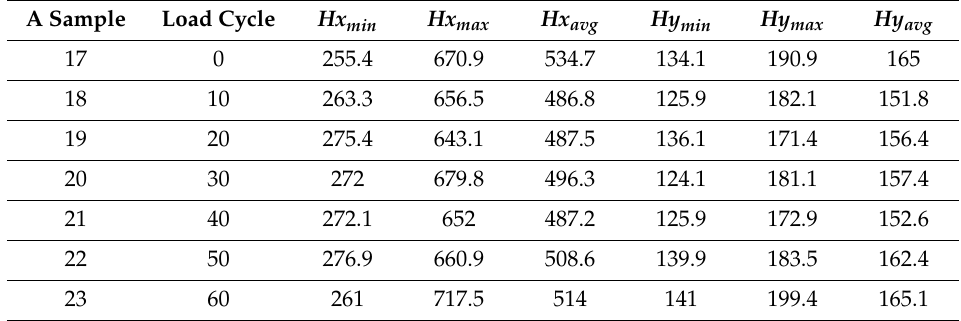
Table 2. Minimum, maximum, and average values of tangential and normal component of the magnetic signals for experiments E.